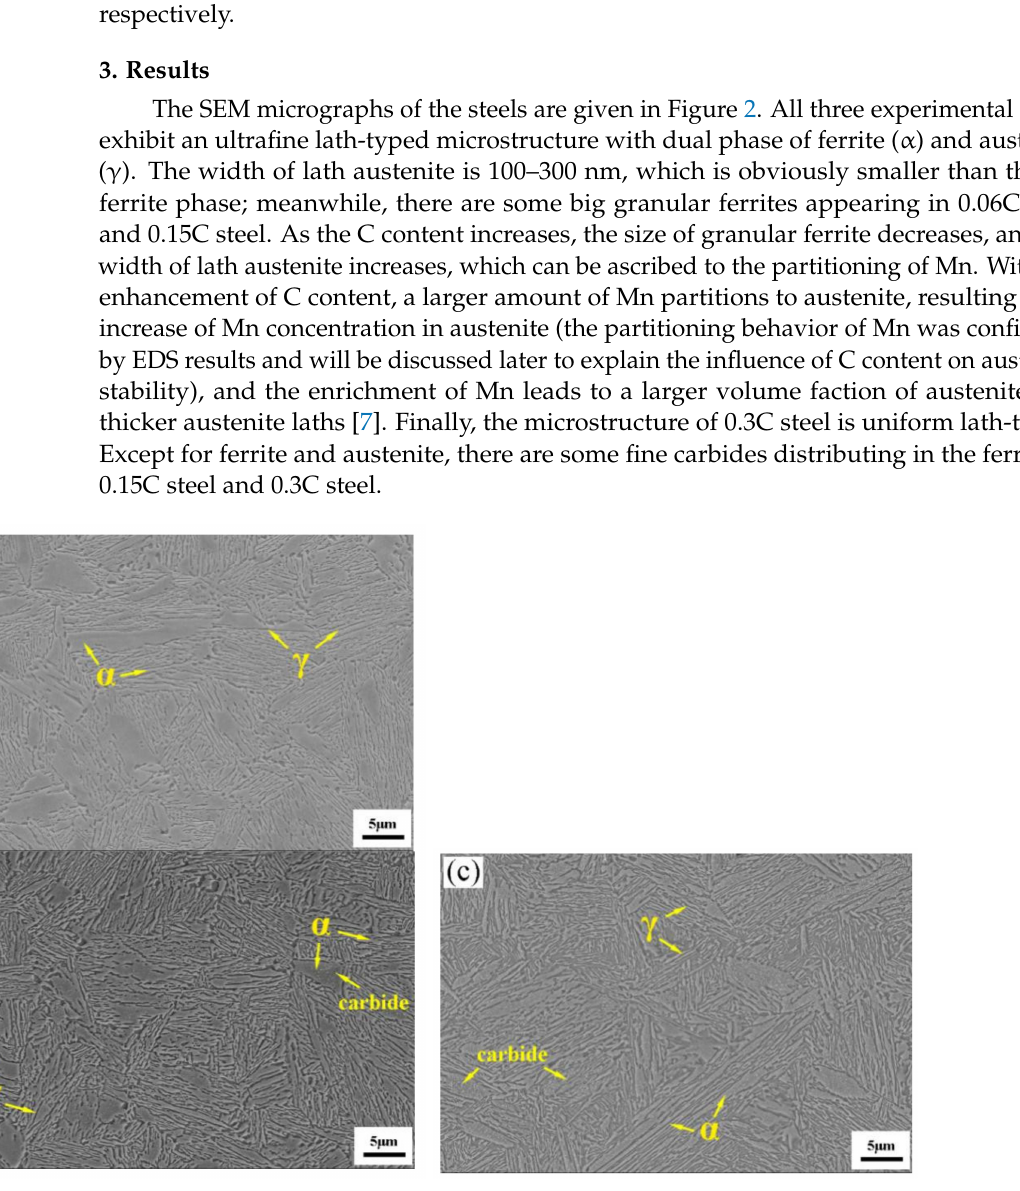
Figure 2. SEM micrographs of the hot-rolled samples after intercritical annealing at 635 ◦ C. ( a ) 0.06C steel. ( b ) 0.15C steel. ( c ) 0.3C